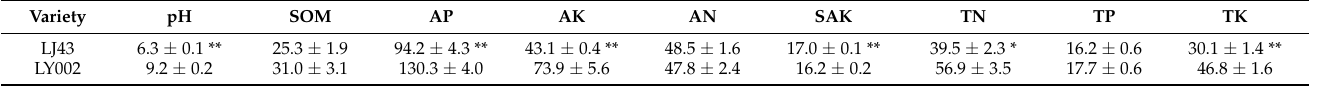
Table 1. Variation coefficients of various soil nutrient indicators.